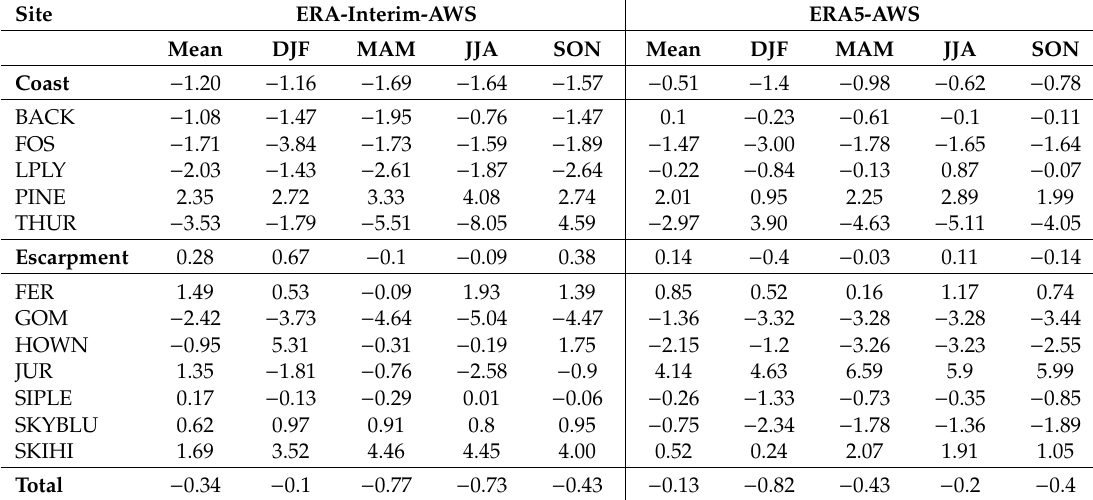
Table 3. Seasonal temperature bias. DJF: December-January-February. MAM: March-April-May. JJA: June-July-August. SON: September-October-November.